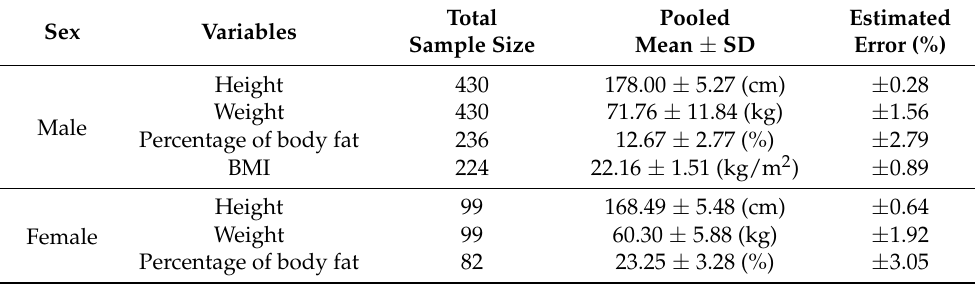
Table 3. Pooled and estimated statistics for the Taekwondo athletes’ physical characteristics.